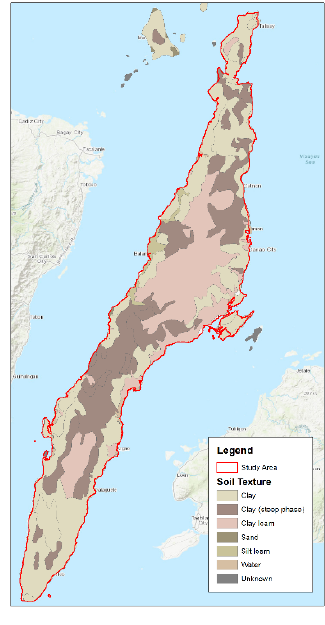
Figure 3. Soil Texture Map